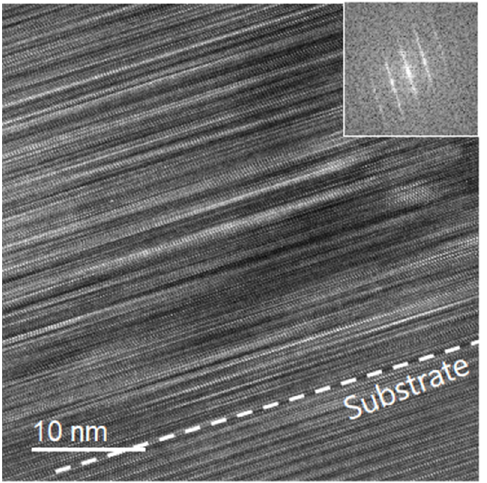
Figure 6. TEM cross-section and FFT images of a SiC film deposited at a (SiH 4 + CH 4 ) / H 2 gas ratio of 0.01, wire bias of − 50 V and distance of 2 mm between the wires and the substrate.